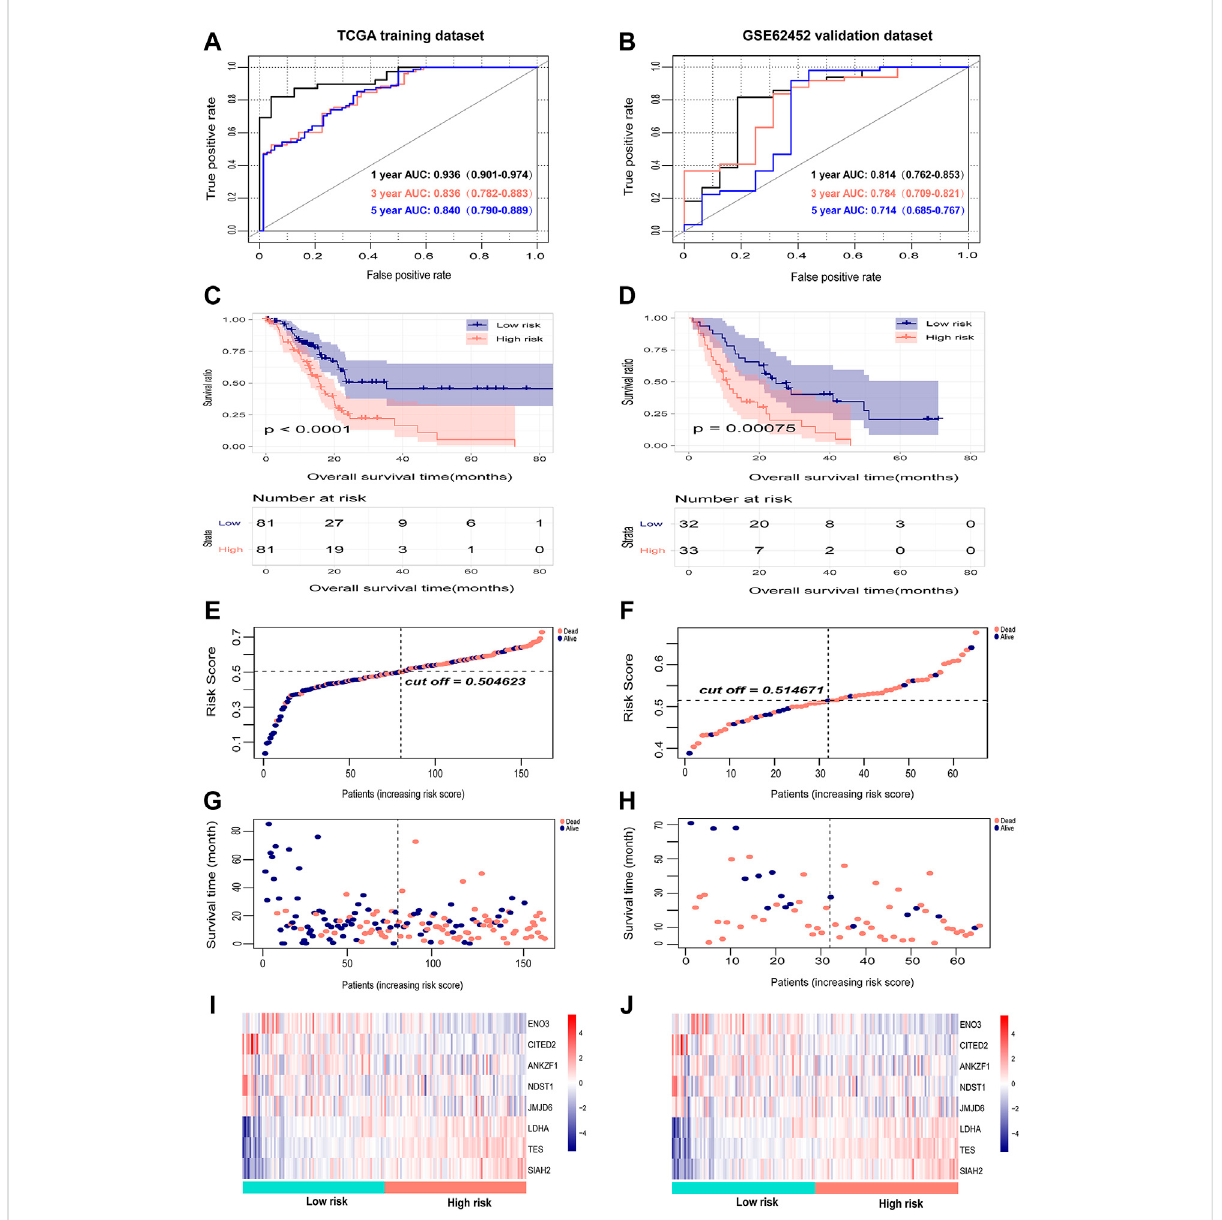
FIGURE 4 Internal evaluation and external validation of the prognostic performance of the eight-gene signature. (A,B) Time-dependent ROC analysis of the eight-gene signature for survival prediction in the TCGA training cohort and GSE62452 testing cohort. (C,D) Kaplan-Meier analysis of the correlation between the risk score and the OS of PAAD patients. (E,F) The distribution of the eight-gene risk scores of each PAAD patient. (G,H) Survival status of PAAD patients ranked by risk score. (I,J) The mRNA expression heatmap of the eight genes in the low- and high-risk groups. Red represents upregulation, and blue represents